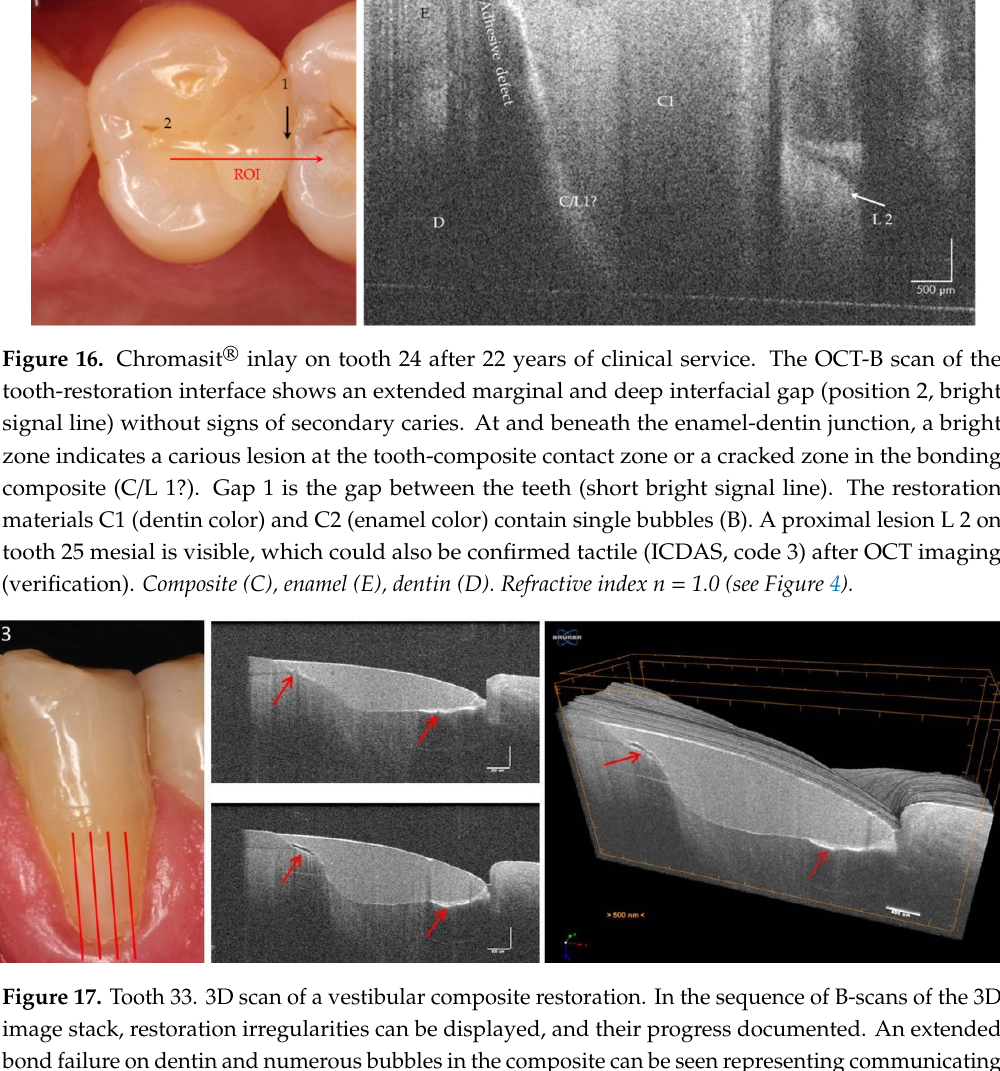
Figure 17. Tooth 33. 3D scan of a vestibular composite restoration. In the sequence of B-scans of the 3D image stack, restoration irregularities can be displayed, and their progress documented. An extended bond failure on dentin and numerous bubbles in the composite can be seen representing communicating tubes (red arrows). Such irregularities can, for example, lead to marginal or restoration discoloration and restoration loss. In clinical studies, these parameters are used to evaluate restoration systems [24]. The vertical scales are related to refractive index n = 1.0.